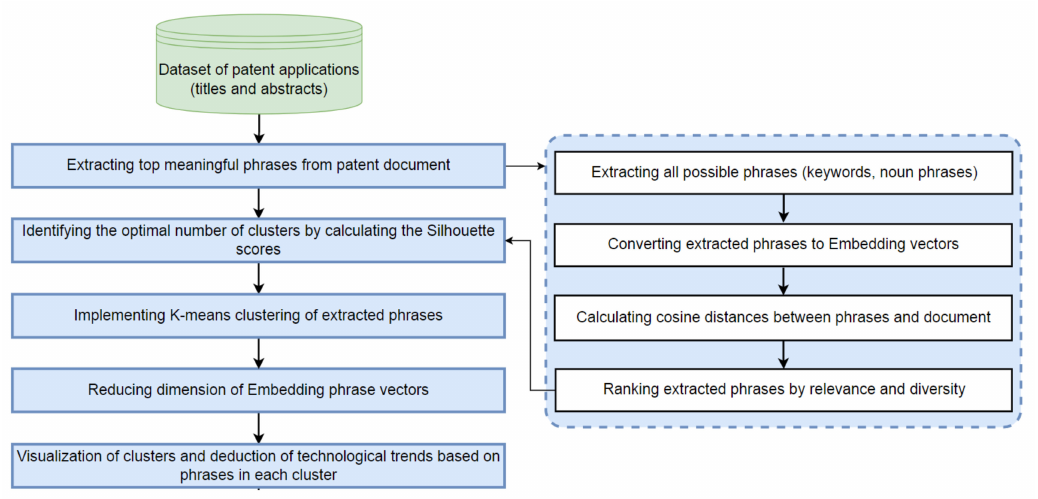
Figure 11. Method for analyzing patents by clustering extracted